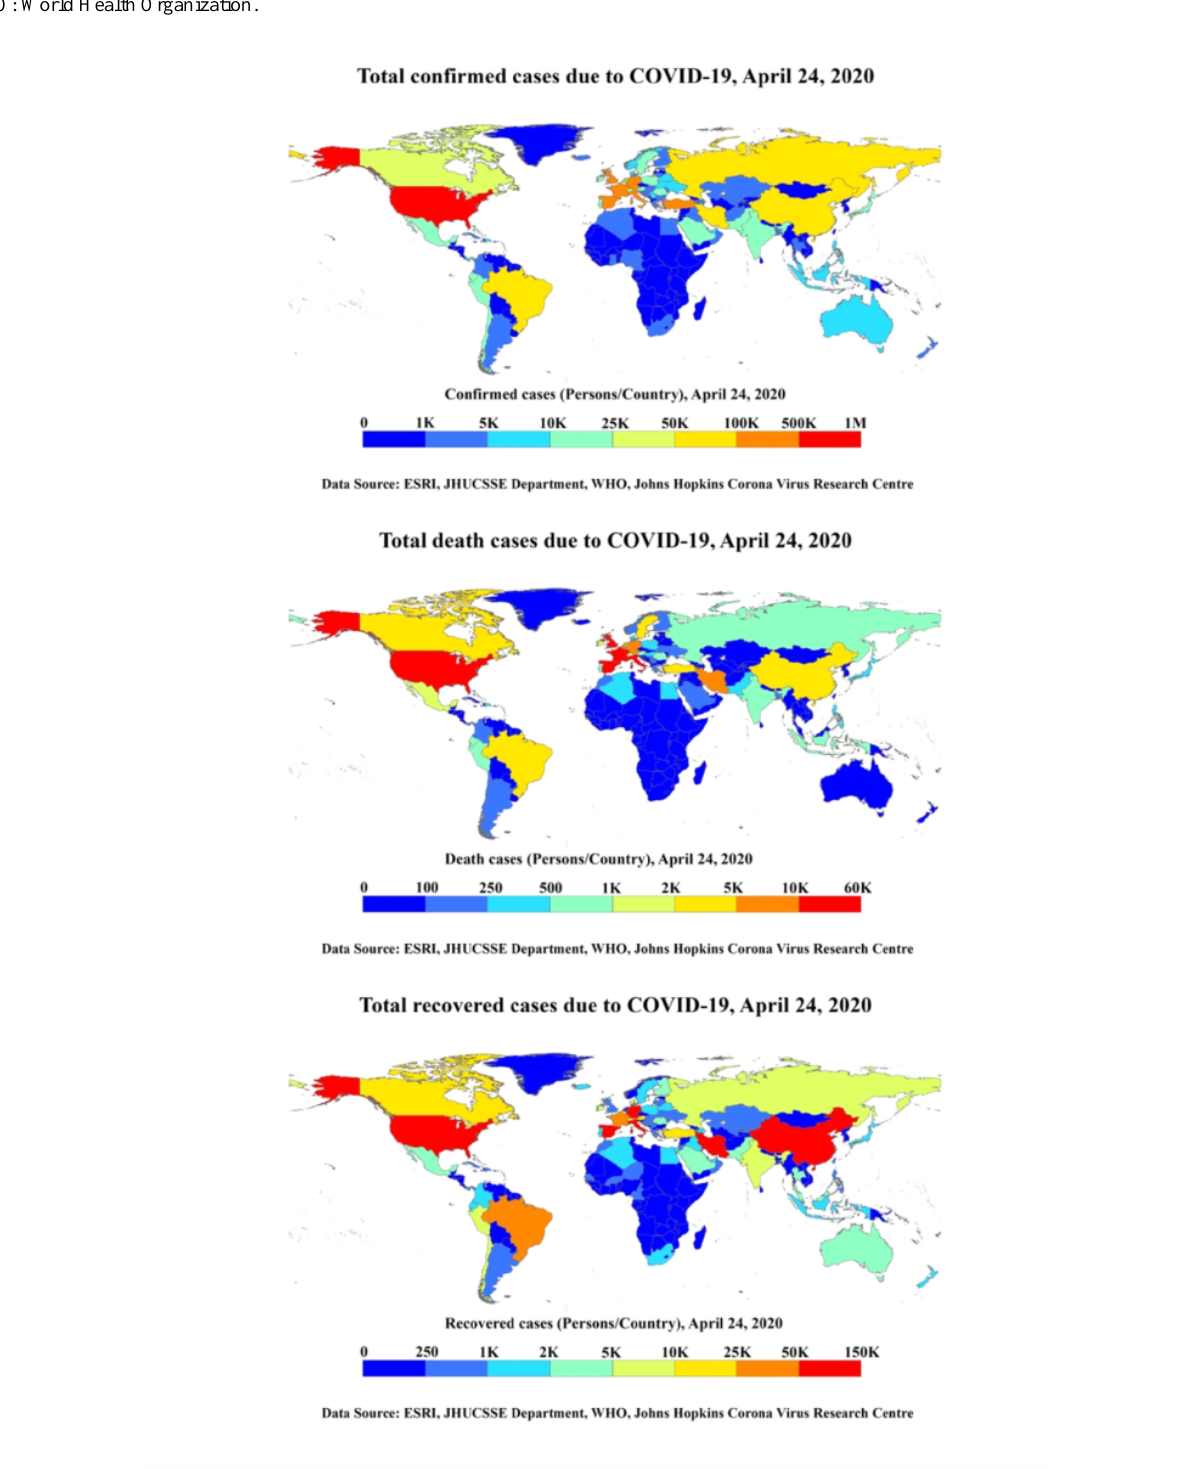
Figure 1. COVID-19 pandemic spatial pattern of total confirmed cases (top), deaths (middle), and recoveries (bottom) from January 19 to April 24, 2020, in countries and territories. COVID-19: coronavirus disease; JHUCSSE: Johns Hopkins University Center for Systems Science and Engineering; WHO: World Health